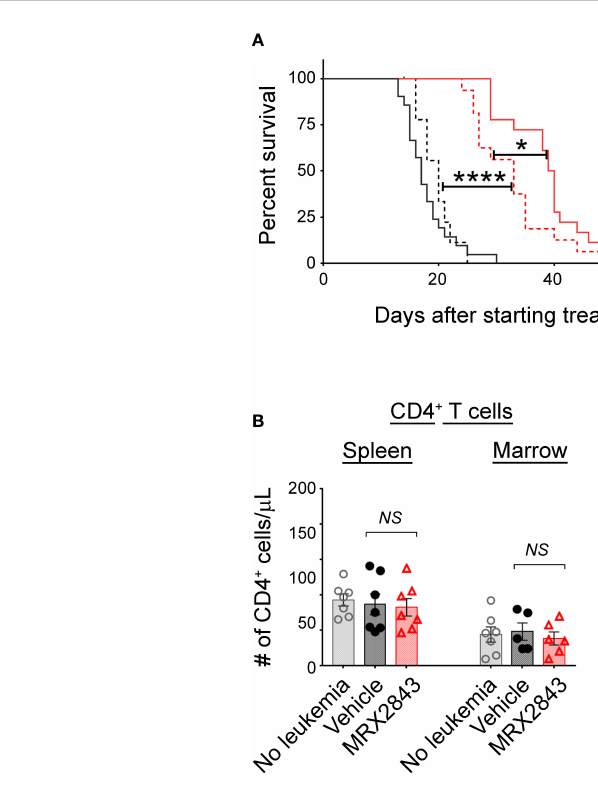
FIGURE 4 MerTK Inhibition on LAMs effects T cells in the leukemia microenvironment. As described in Figure 1G, mice were inoculated with AML and treated with MRX2843 or vehicle. (A) Cohorts of mice lacking the a chain of the T cell receptor (TCR a -/- ) were inoculated with AML and treated equivalently to those described in Figure 1B. Symptom-free survival was recorded; Kaplan-Meier curve of TCR a -/- mice treated with MRX2843 (dashed red line; n = 17) or vehicle (dashed black line, n = 9) with the superimposed wild-type C57BL/6 mice described in Figure 1B treated with MRX2843 (solid red line) and vehicle (solid black line). (B) Three weeks after inoculation, harvested spleen and marrow from MRX2843 or vehicle-treated mice were analyzed by fl ow cytometry. Quanti fi cation of CD4+ and CD8+ T cells was analyzed using 1-way ANOVA. (*p<0.05, ****p<0.0001, NS, not signi fi